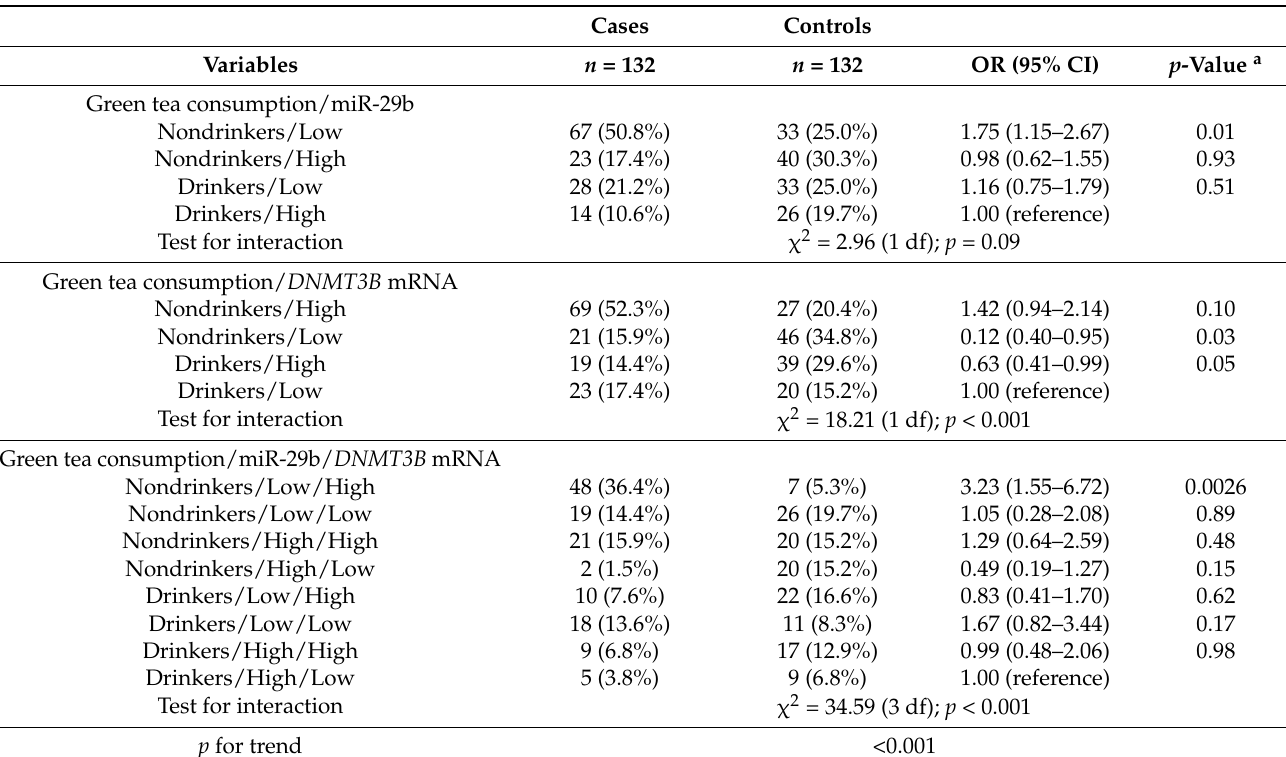
Table 5. Combined effects of green tea consumption with miR-29b and DNMT3B mRNA in lung cancer